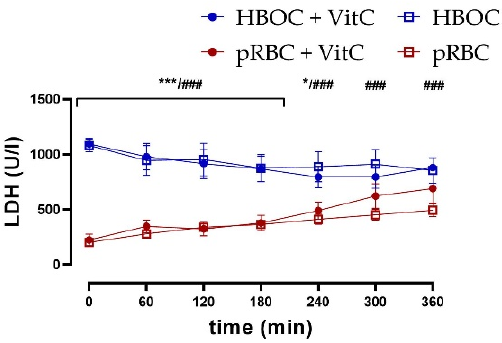
Figure 5. LDH perfusate concentrations were significantly higher in the HBOC groups than in pRBC groups without VitC throughout 6 h perfusion (HBOC vs. pRBC; ### p < 0.001) and until 240 min with VitC (HBOC + VitC vs. pRBC + VitC 0–180 min; *** p < 0.001, 240 min * p < 0.05).